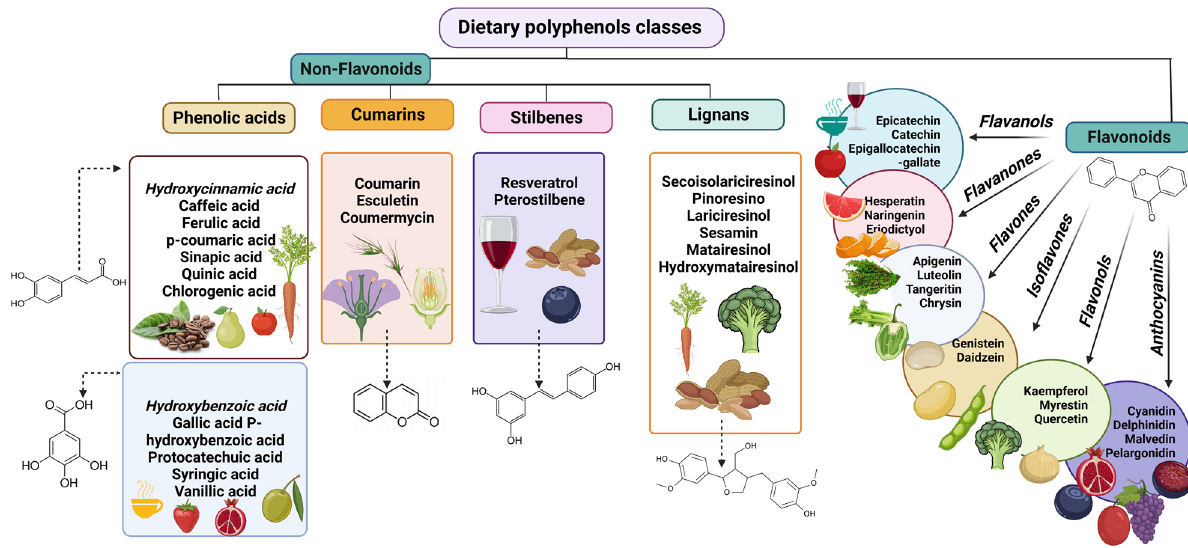
Figure 1. Polyphenol classification .